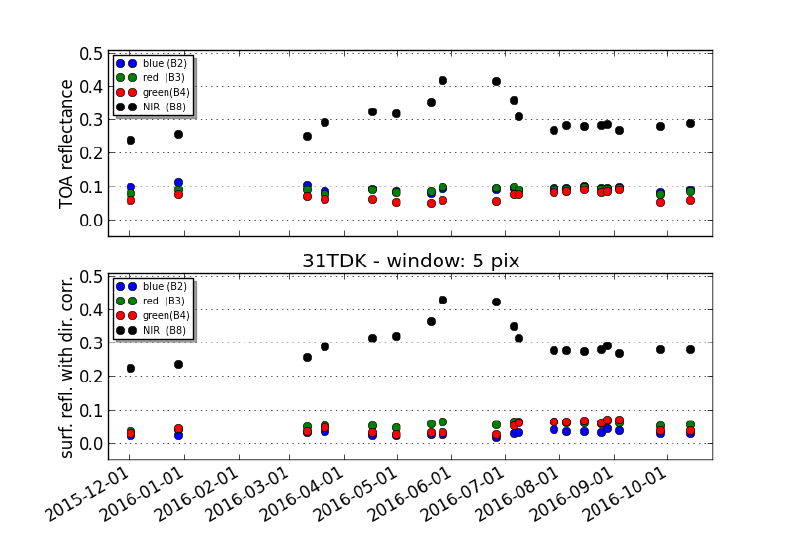
Figure 2. Same as Figure 1, but after removal of the detected clouds and shadows, with top of atmosphere reflectances on the top plot, and on the bottom plot, the surface